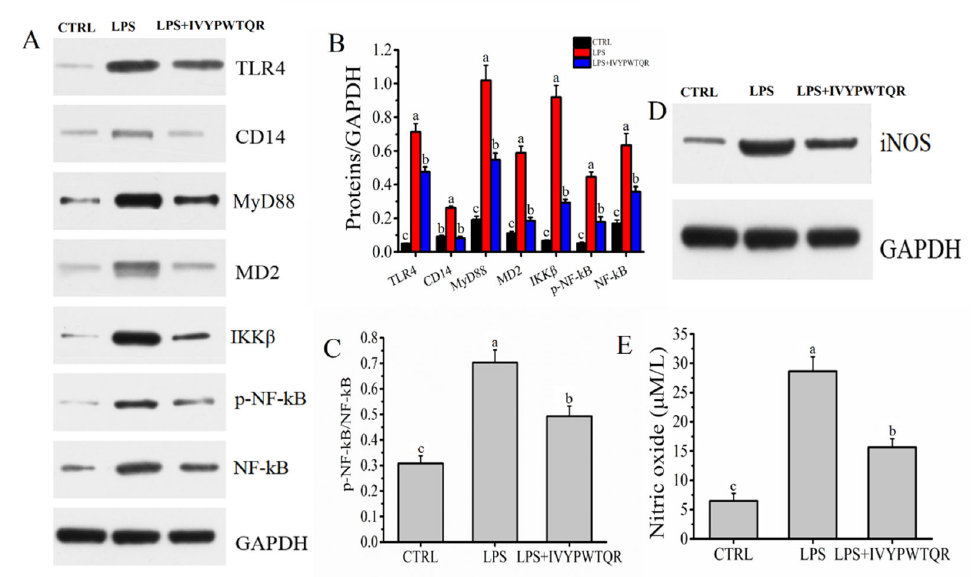
Figure 7. ( A , B ) Effects of IVYPWTQR on the levels of LPS receptors ( TLR4 ), co ‐ receptors ( CD14 and MD2 ), MyD88 , IKK β , p ‐ NF ‐ kB, and NF ‐ kB in LPS ‐ mediated RAW264.7 macrophages; ( C , D ) Effects of IVYPWTQR on the levels of p ‐ NF ‐ kB p65/NF ‐ kB p65 and iNOS in LPS ‐ mediated RAW264.7 mac ‐